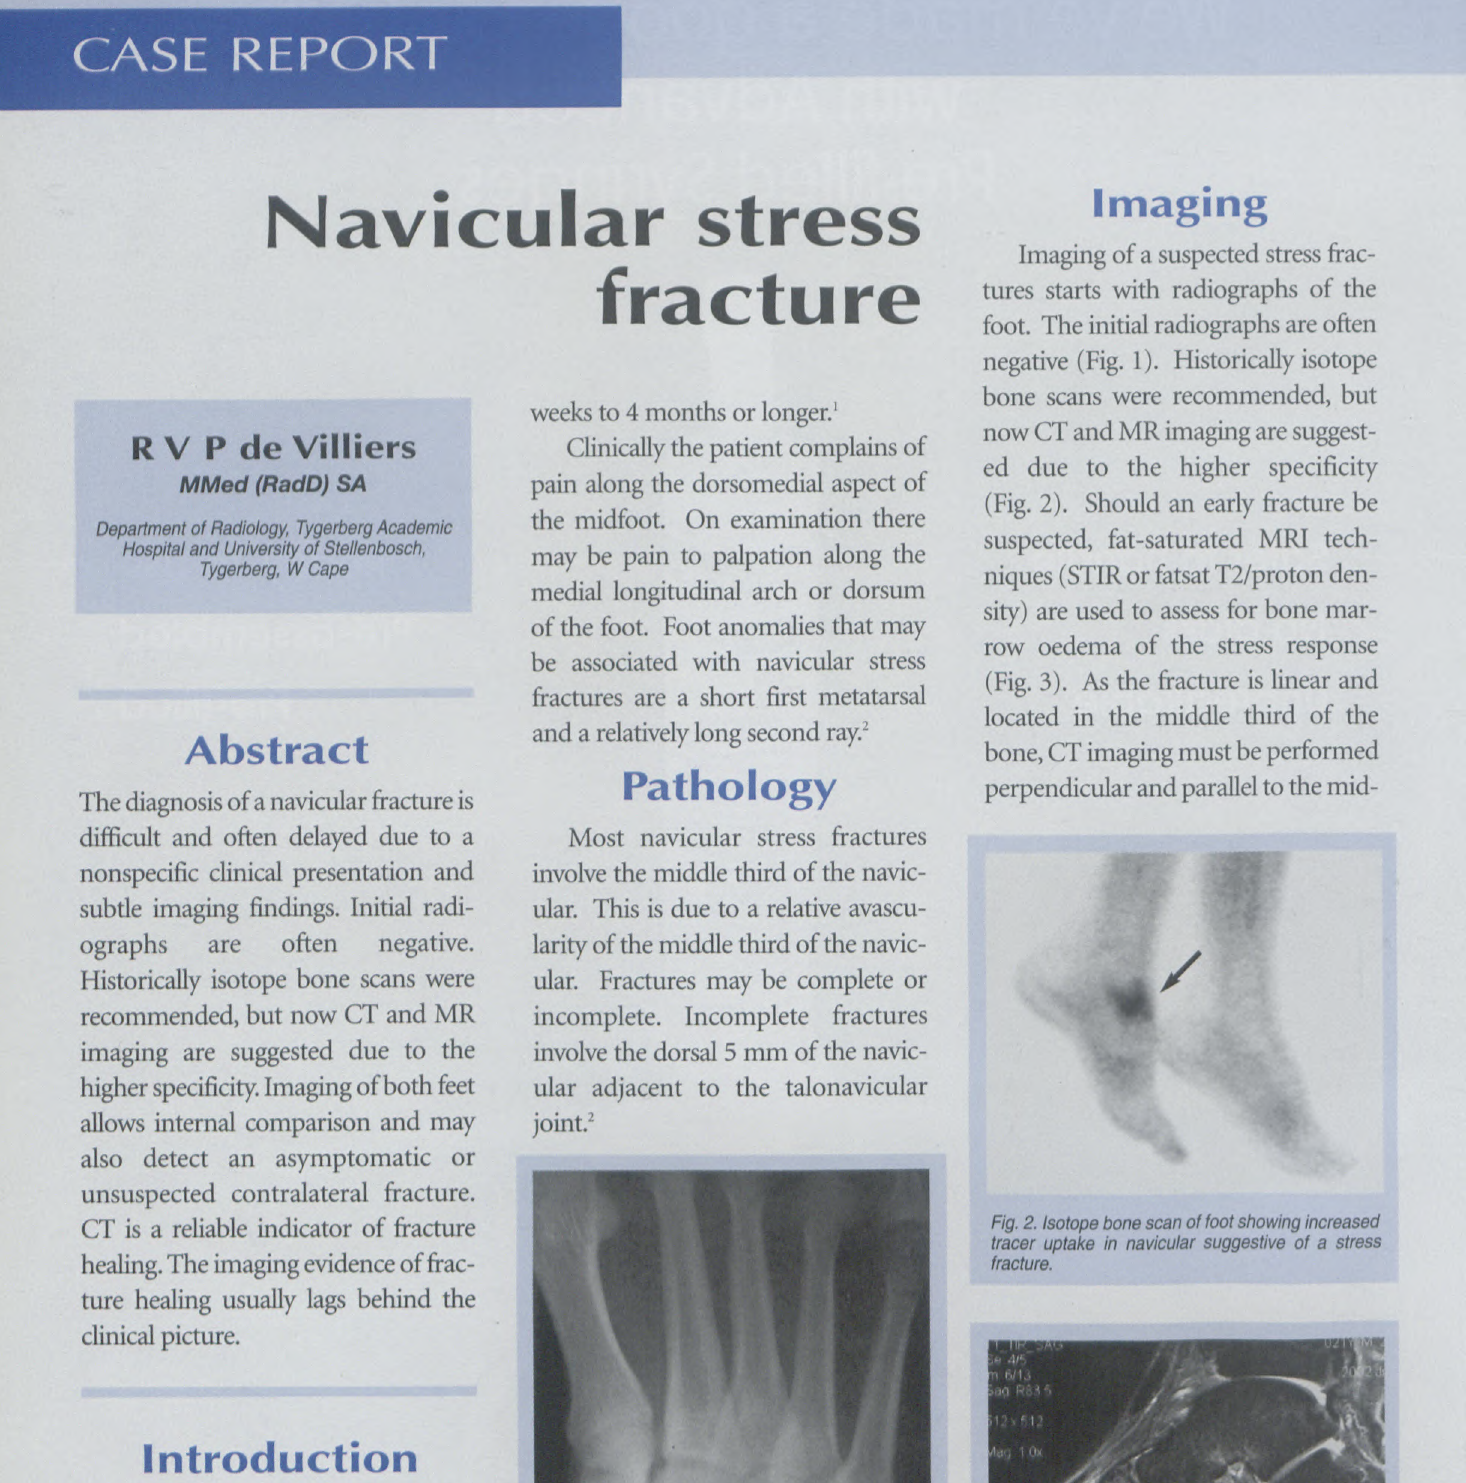
Fig. 3. MRI of the foot. Sagittal STIR image. Note increased signal intensity in the navicular with asso- ciated fracture line compatible with occult fracture. No fracture was present on the plain